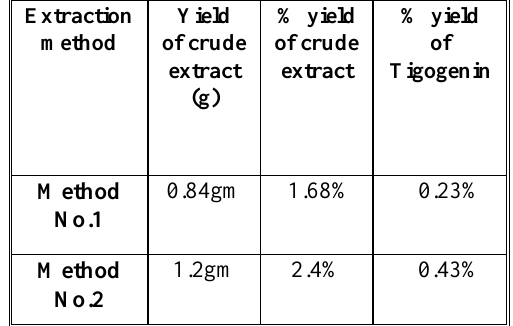
Table (1): Quantitative of crud extracts and Tigogenin obtained from extraction methods.